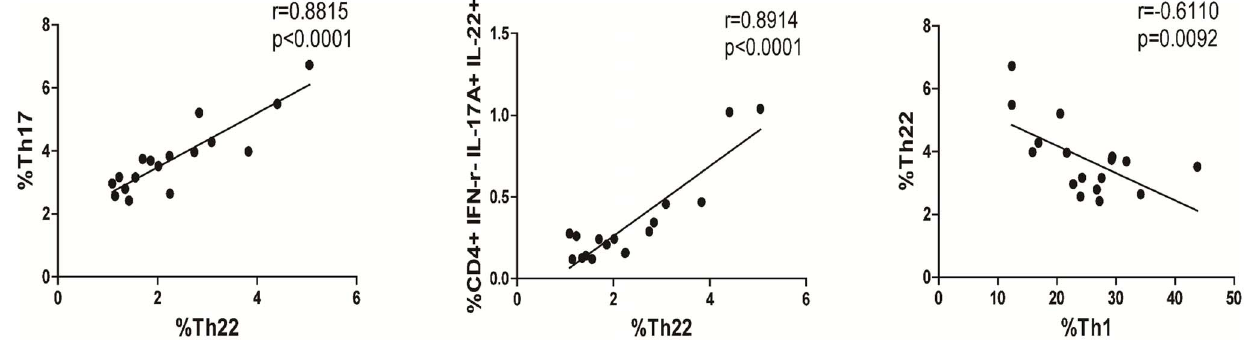
Figure 2. Correlation between percentages of different subsets of CD4 + T cells in HT patients. The potential correlations among the different subsets of CD4 + T cells were analyzed by Spearman’s rank correlation test. Data shown are the mean values of individual patient